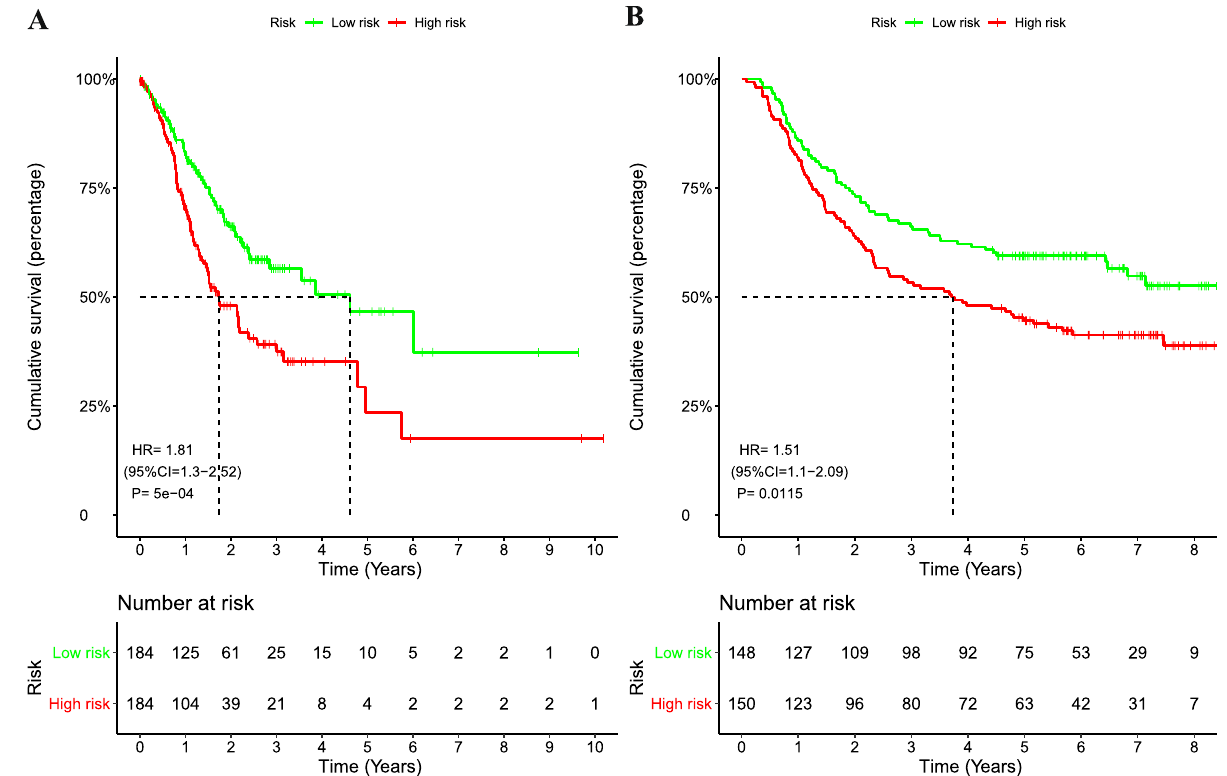
Figure 2. Kaplan–Meier survival analysis of the signature risk score between the high- and low-risk groups. Survival differences in the TCGA cohort ( A ), and the GSE66229 validation cohort ( B